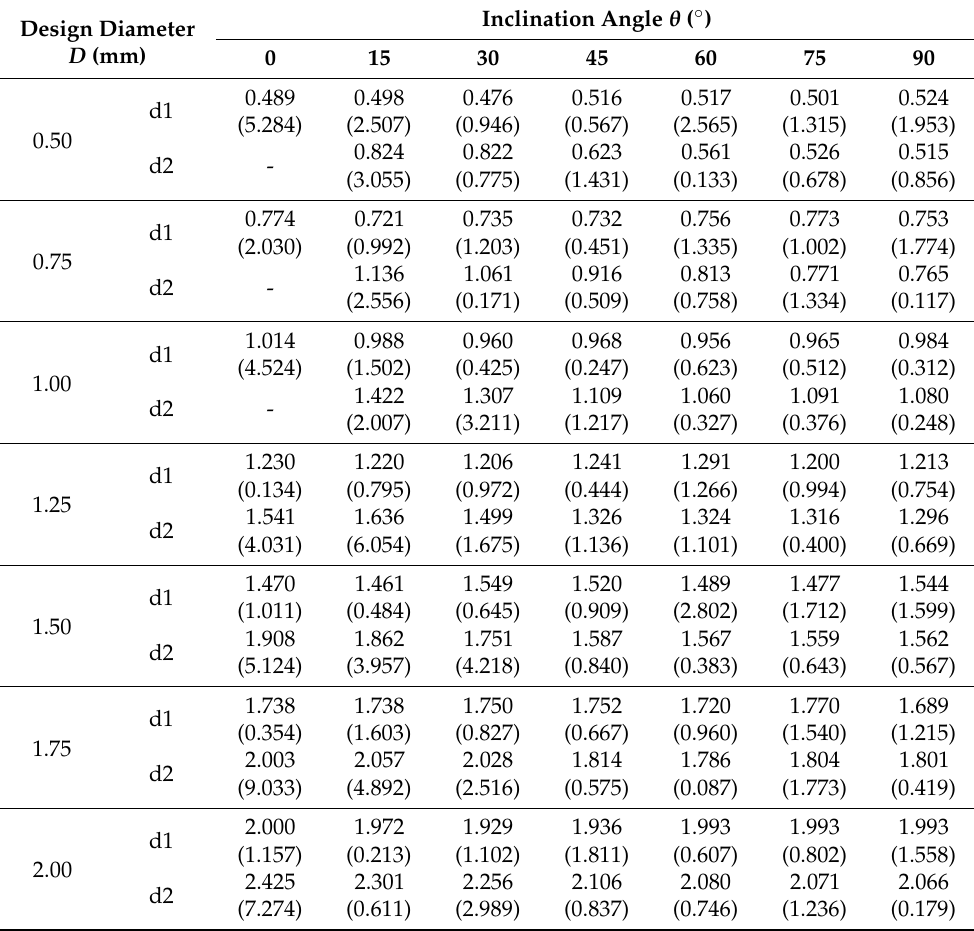
Figure 6. Schematic view of the rod diameters size measurement. Table 3. The average diameter of the rod unit (mm)and standard deviation (in the brackets). Design Diameter